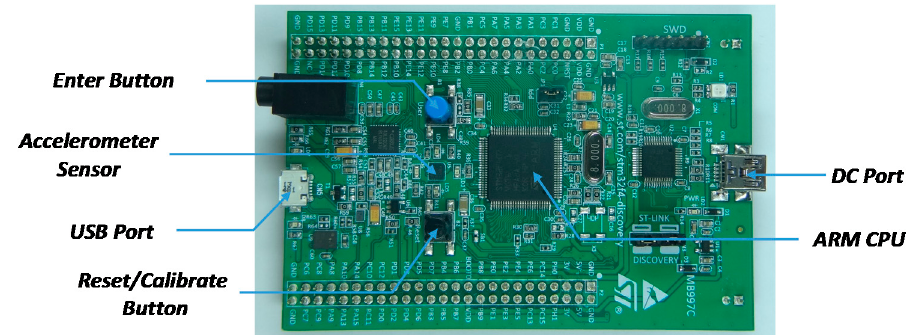
Figure 8. Data acquisition system based on the STM32F4-Discovery board.